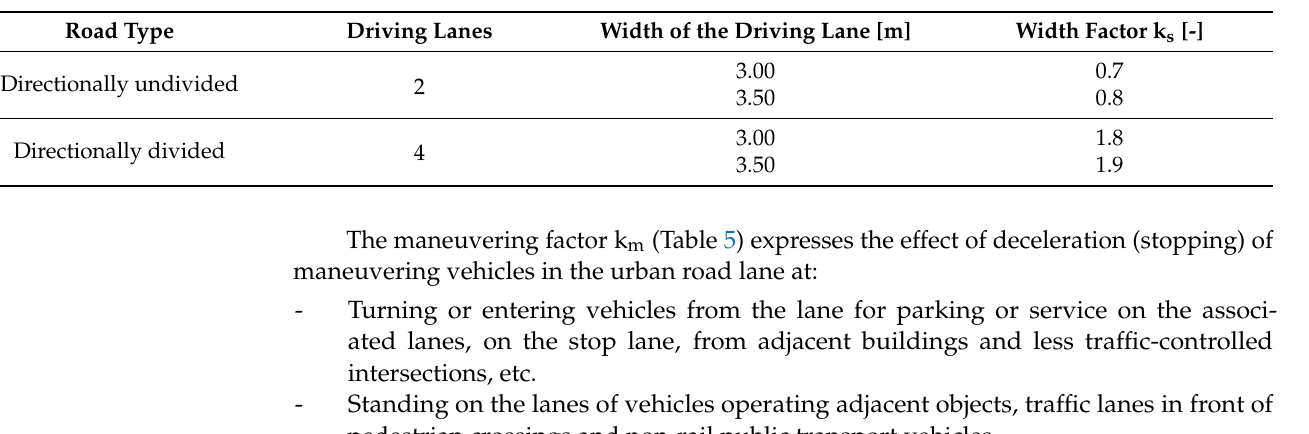
Table 4. Width factor k s for two- to eight-lane urban road arrangement [65].